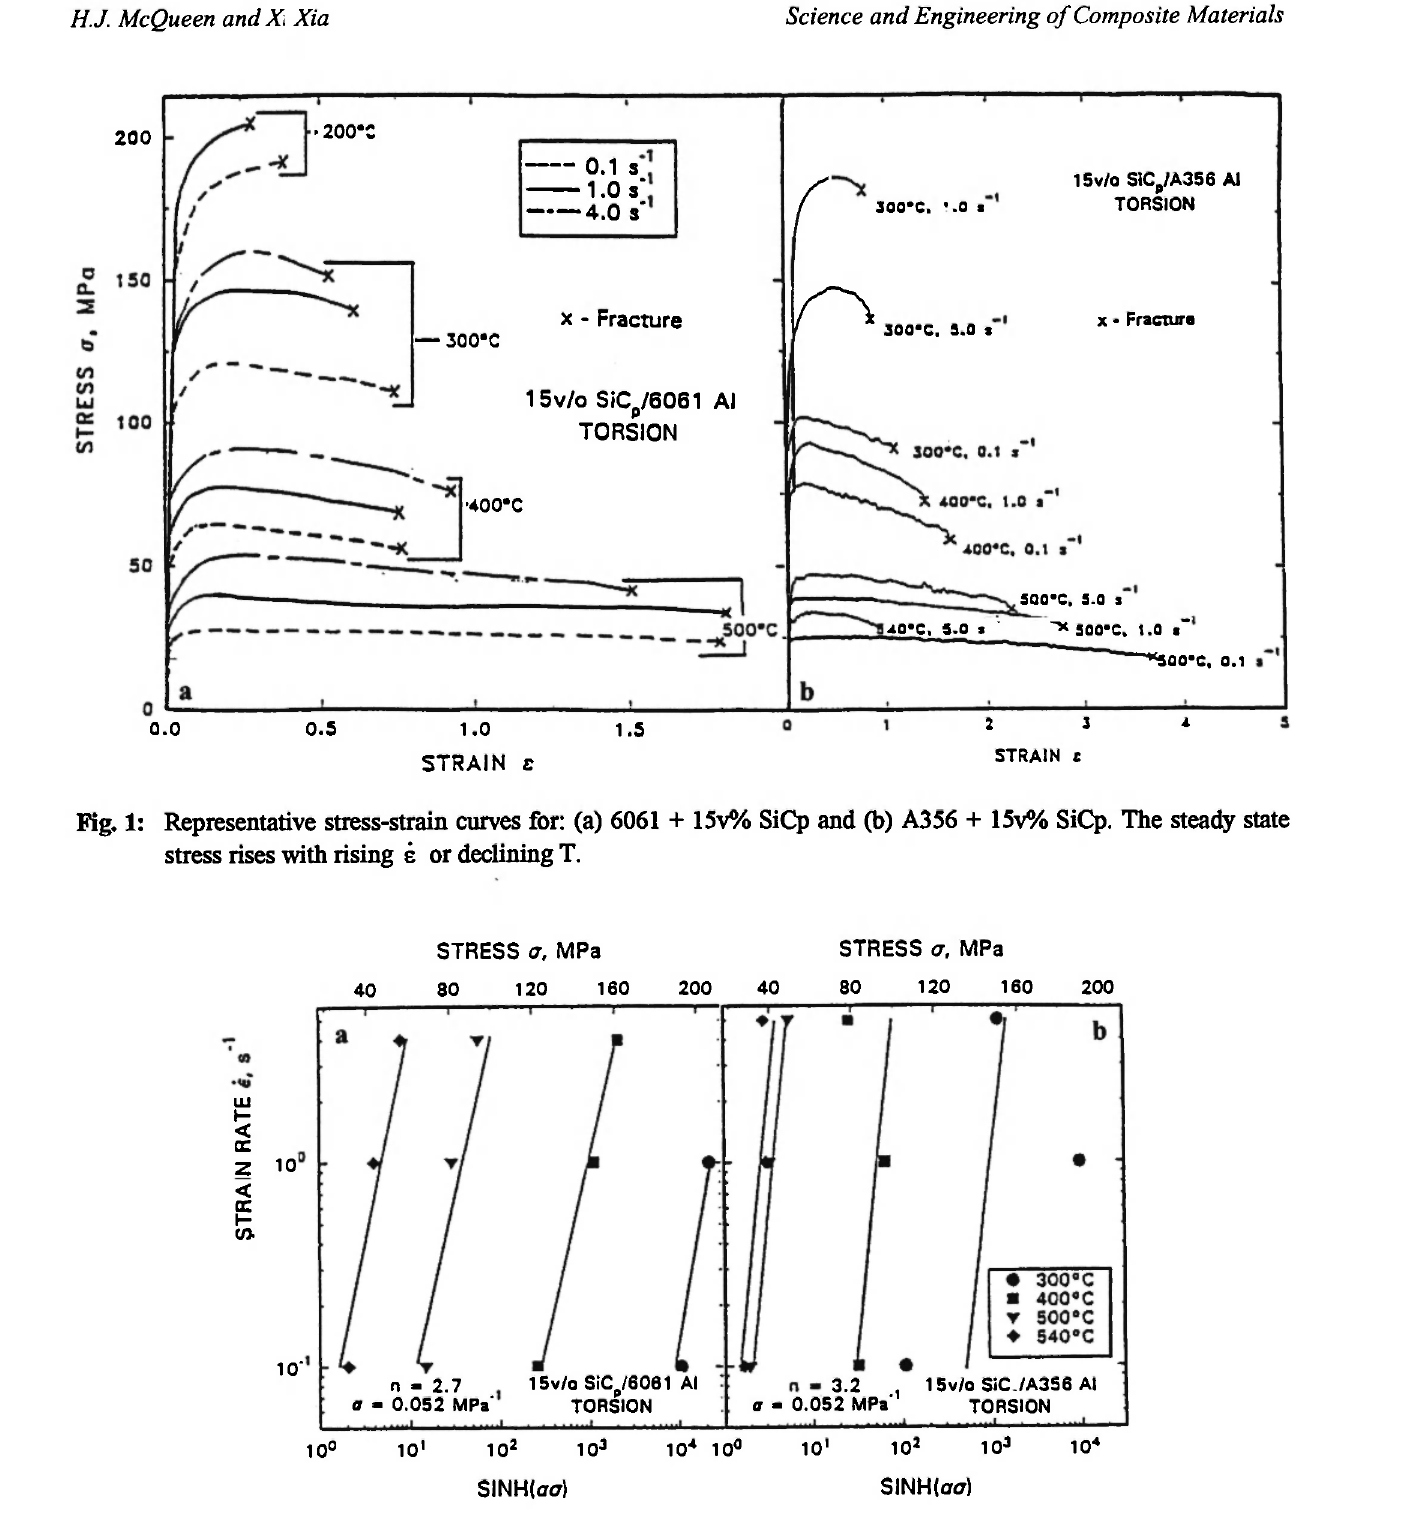
Fig. 2: Ductilities for: (a) 6061 + 15v% SiCp and (b) A356 + 15v% SiCp increase with rising temperature to pass through maxima near 500°C, while the flow stress is declining in accordance with the Arrhenius relationship of Eqn. 1 (c,d). Straight lines can be drawn and a single activation energy can be